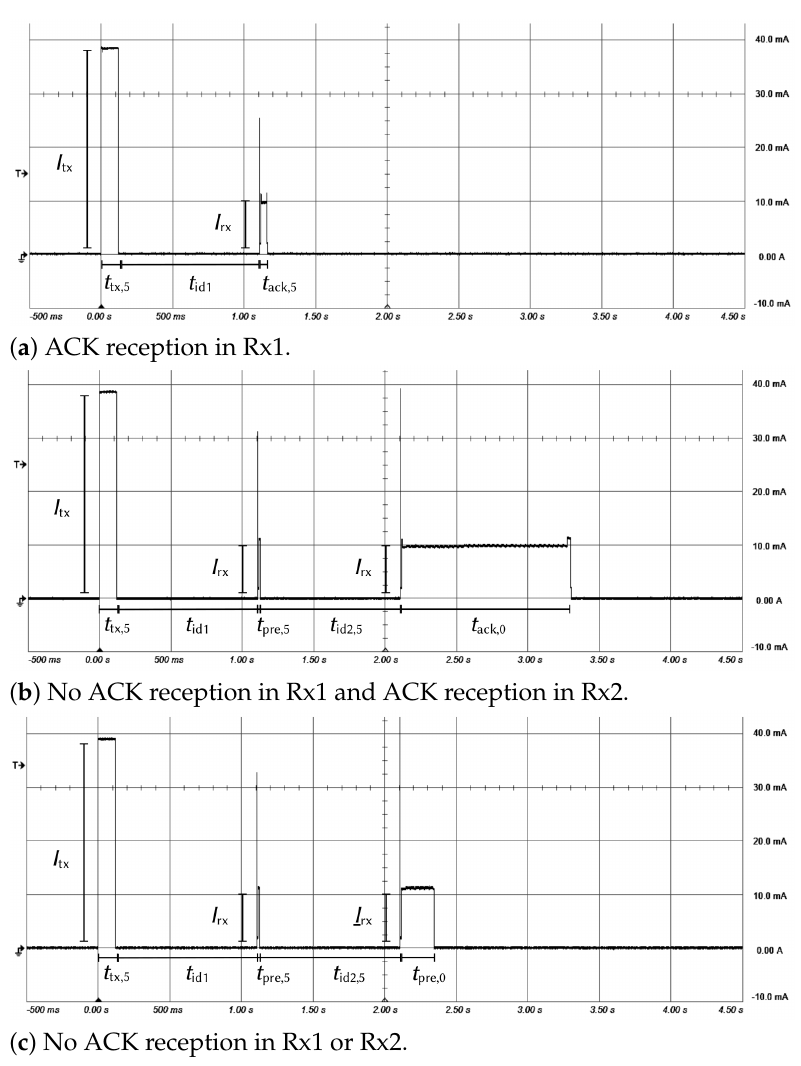
Figure 10. Measured current in various transmission phases (P tx = 14 dBm, DR =